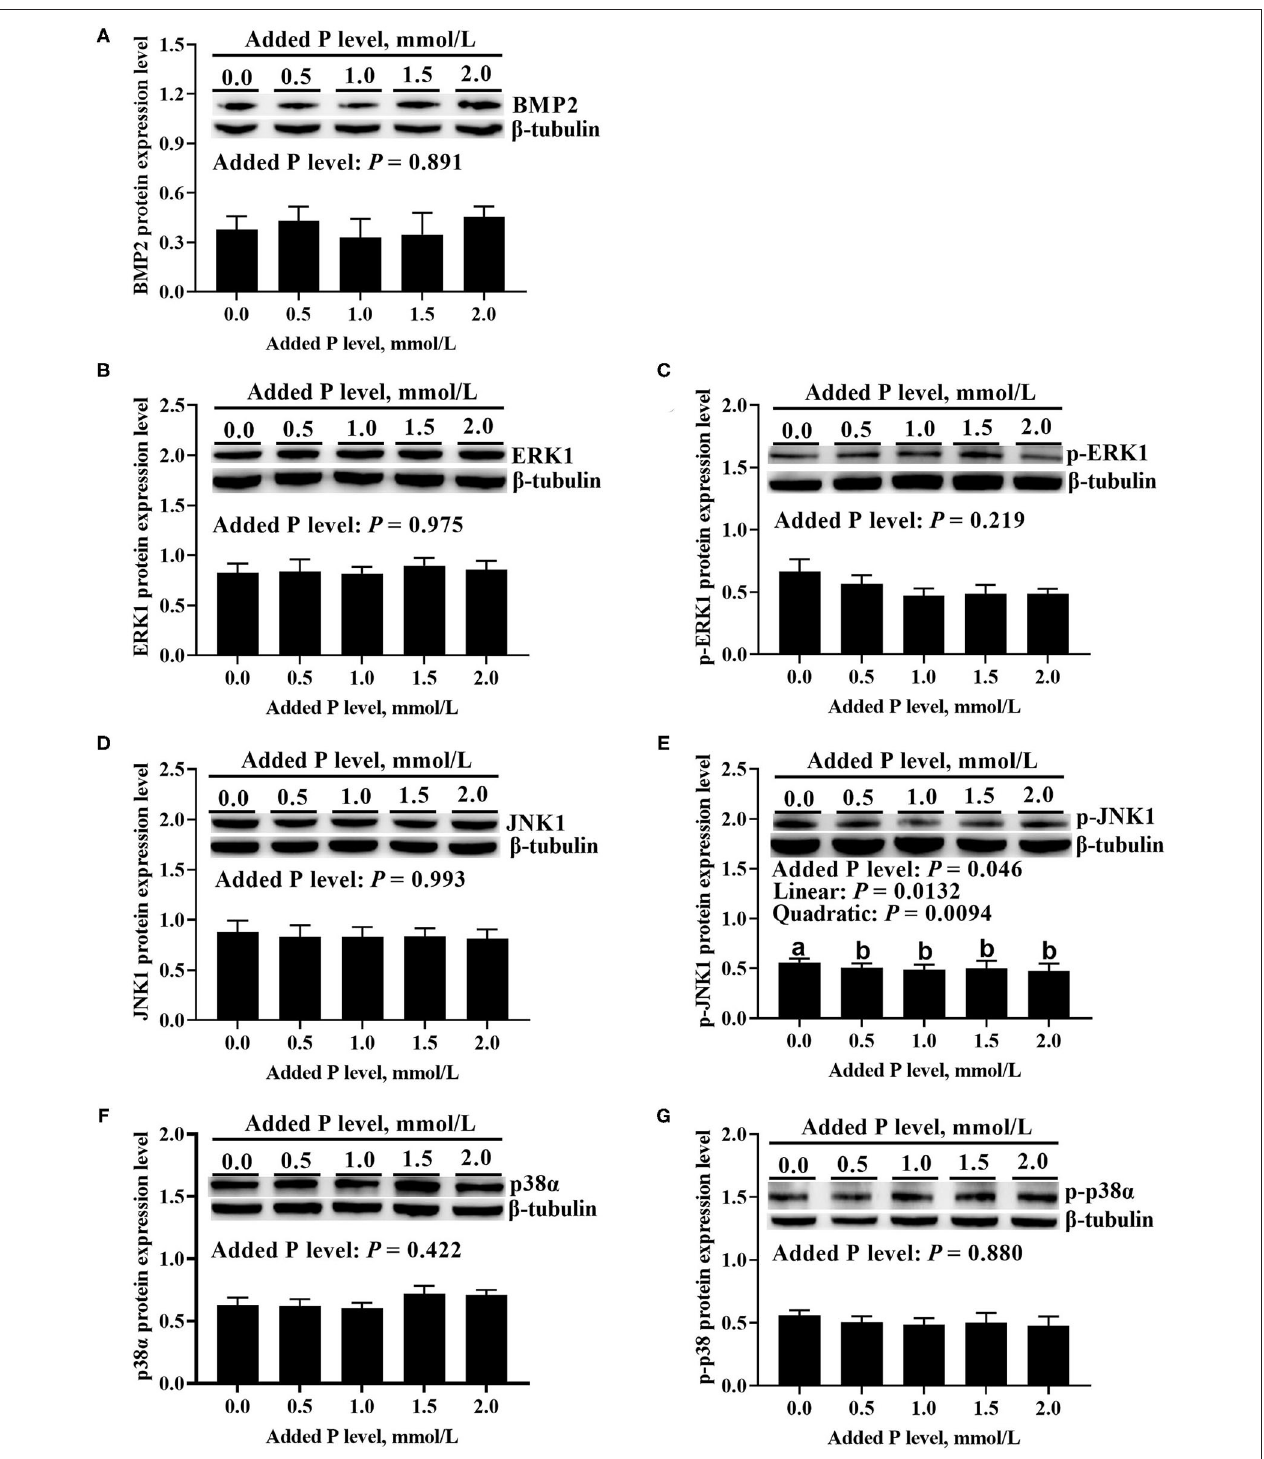
FIGURE 6 | Effect of added P level on BMP2 protein expression level (A) , total and phosphorylated protein expression levels of ERK1 (B,C) , JNK1 (D,E) , and p38 α (F,G) in primary cultured tibial osteoblasts of broiler chicks. Representative Western blots for these proteins were shown. Each value was mean ± SE, n = 6. Means without a common letter differ, p ≤ 0.05. BMP2, bone morphogenetic protein 2; ERK1, extracellular signal-regulated kinase 1; p-ERK1, phosphorylated extracellular signal-regulated kinase 1; JNK1, c-Jun N-terminal kinase 1; p-JNK1, phosphorylated c-Jun N-terminal kinase 1; p38 α , p38 mitogen-activated protein kinase alpha; p-p38 α , phosphorylated p38 mitogen-activated protein kinase